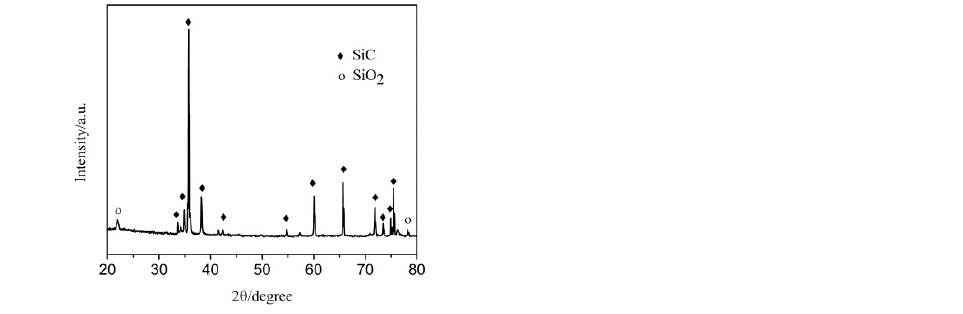
Figure 2. XRD pattern of the SiC coated C/C sample after oxidation at 1773 K in air for 20 min.